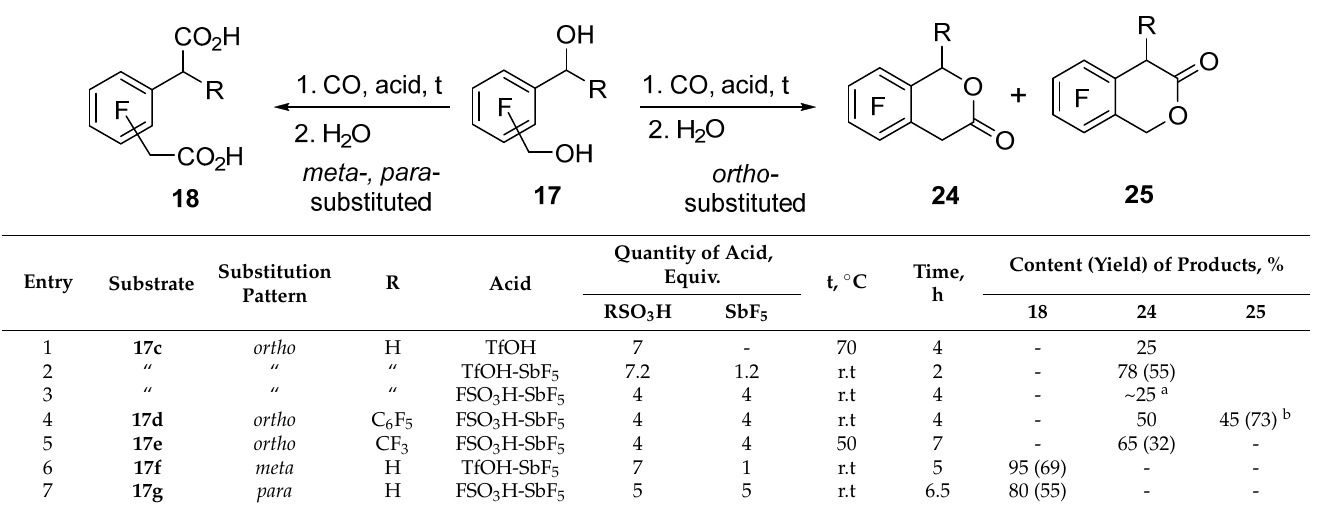
Table 4. Carbonylation of polyfluorinated diols 17c – g in superacids.